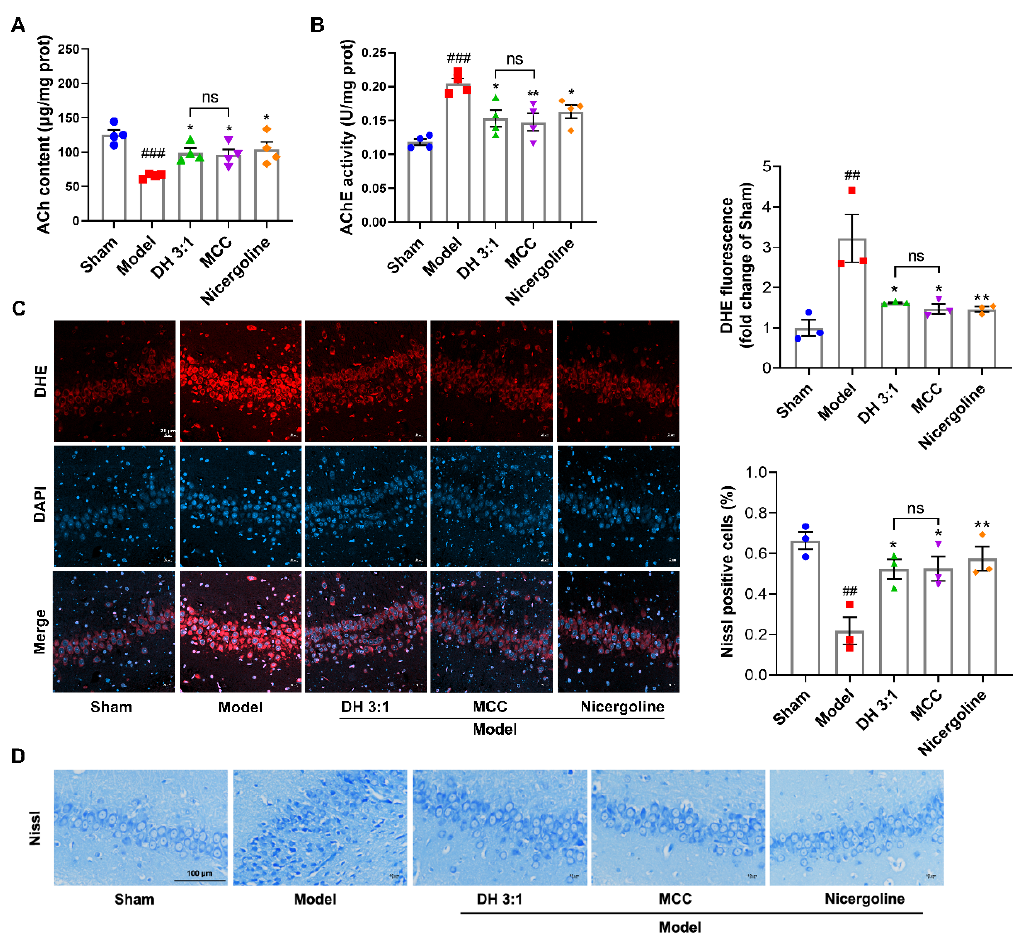
Figure 7. The MCC showed an equivalent neuroprotective effect to the DH herbal pair in VaD rats. ( A , B ) Acetylcholine (ACh) content and acetylcholinesterase (AChE) activity in the hippocampal tissues were measured. ( C ) ROS production in the hippocampal CA3 area was labeled using DHE staining (scale bar = 20 μ m). ( D ) The neuronal damage in the hippocampal CA3 area was observed using Nissl staining (scale bar = 100 μ m). The data are presented as mean ± SEM (n ≥ 3). DH: Danshen-Honghua; MCC: multi-component combination. * p < 0.05, ** p < 0.01 vs. model group; ## p < 0.01, ### p < 0.001 vs. sham group; ns: no significant difference.